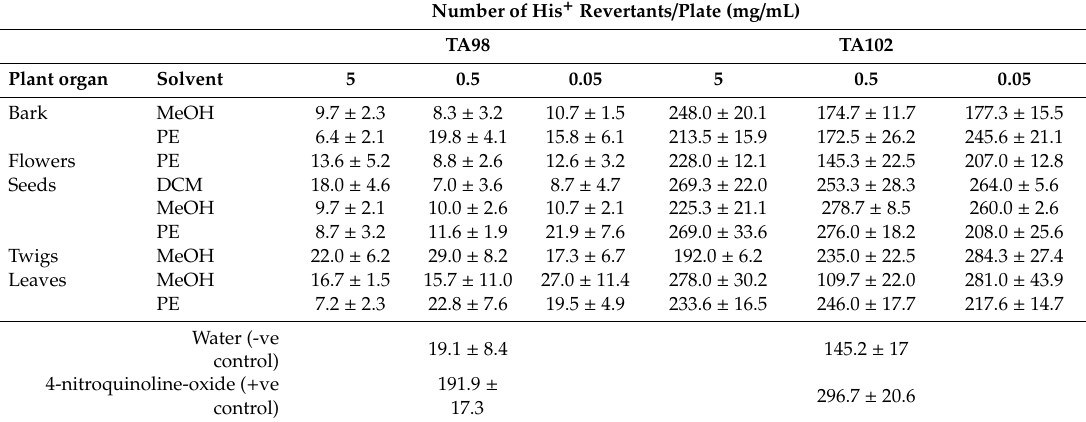
Table 6. Number of His + revertants in Salmonella typhimurium strains TA98 and TA102 produced by Protea ca ff ra organic solvent